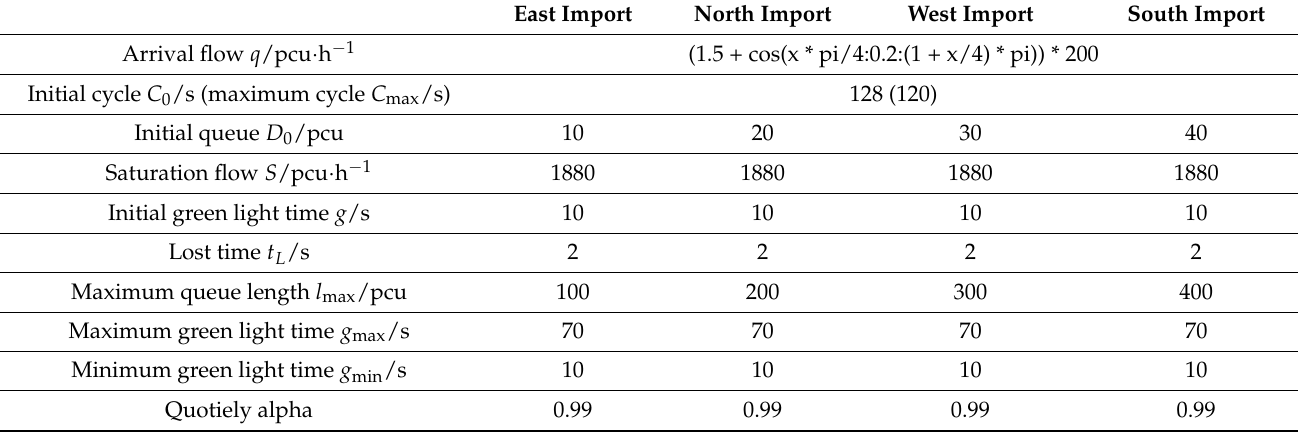
Table 1. The equilibrium control simulation parameter table.